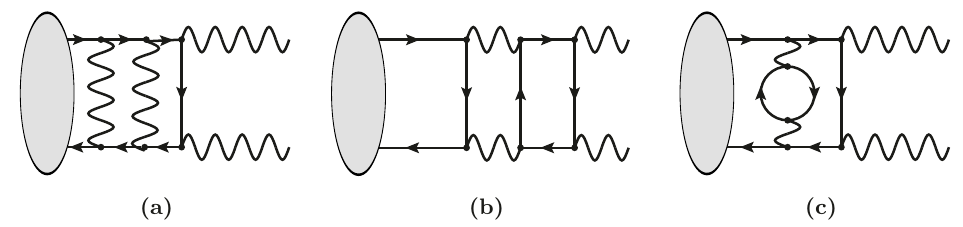
Figure 6. Two-loop diagrams for the decay of para-positronium into two photons with (a) regular corrections, (b) light-by-light contributions and (c) vacuum polarisation